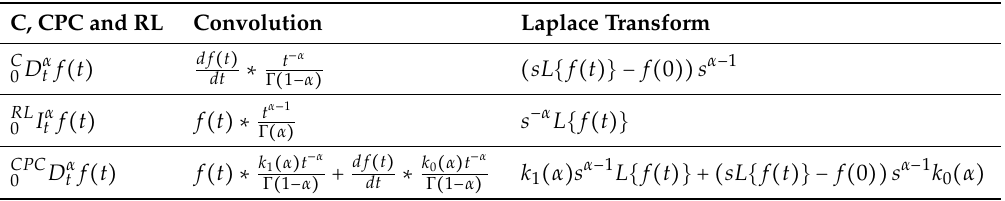
Table 1. Laplace transform of the Caputo (C), constant proportional Caputo (CPC) derivatives and the Riemann–Liouville (RL)